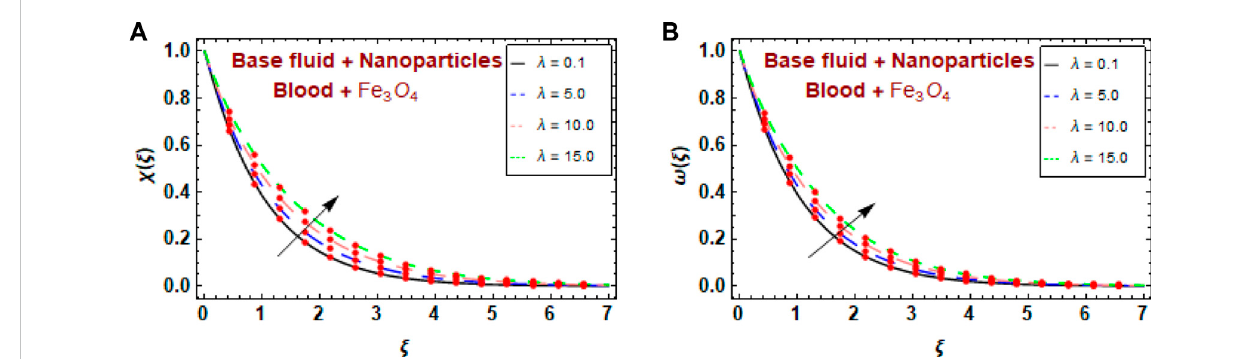
FIGURE 13 (A,B) Variations in χ ( ξ ) for distinct numbers of λ .